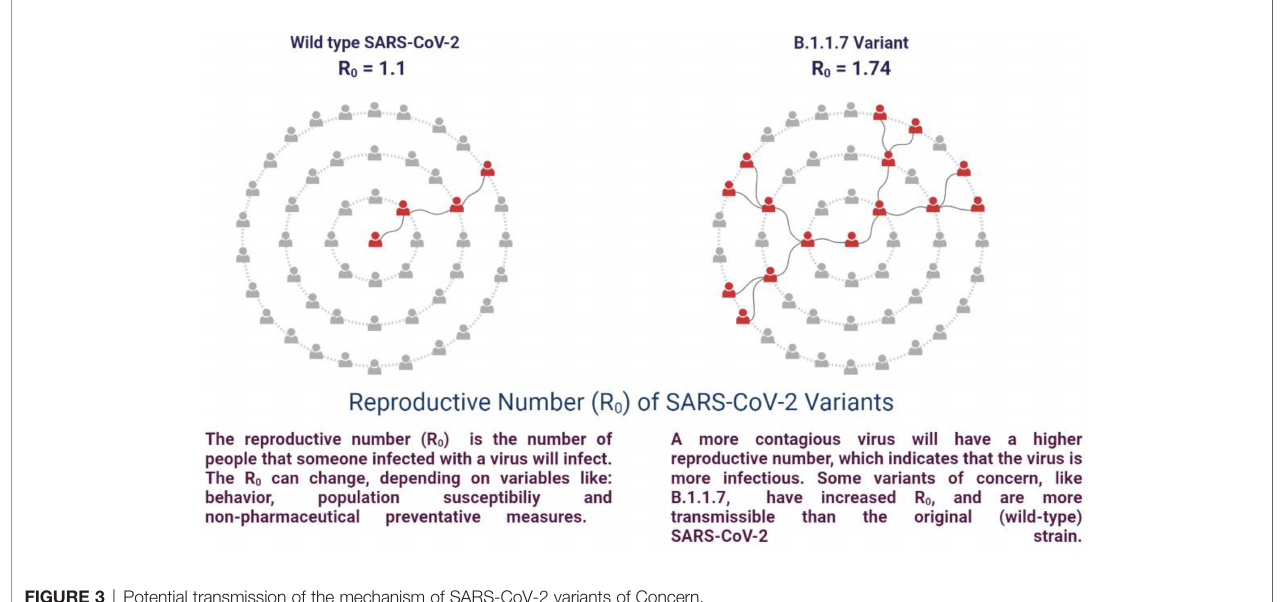
FIGURE 3 | Potential transmission of the mechanism of SARS-CoV-2 variants of